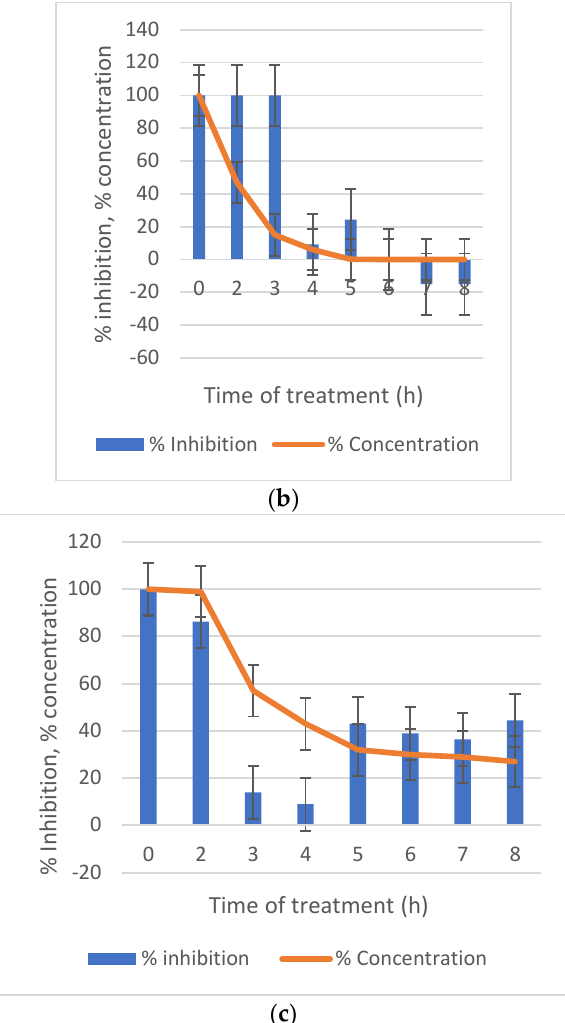
Figure 6. The inhibition of light emission produced by the eight solutions of each compound, including the untreated solutions (time of treatment = 0). ( a ) TBA, ( b ) IMI, ( c ) AZO.